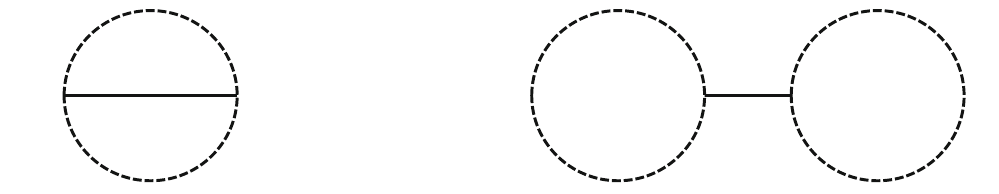
Fig. 3 Contributions to the 2PI effective action up to two loop order. The solid lines denote φ -propagators, whereas the dashed lines correspond to ψ -propagators. The tadpoles will not make any contribution. See main text for